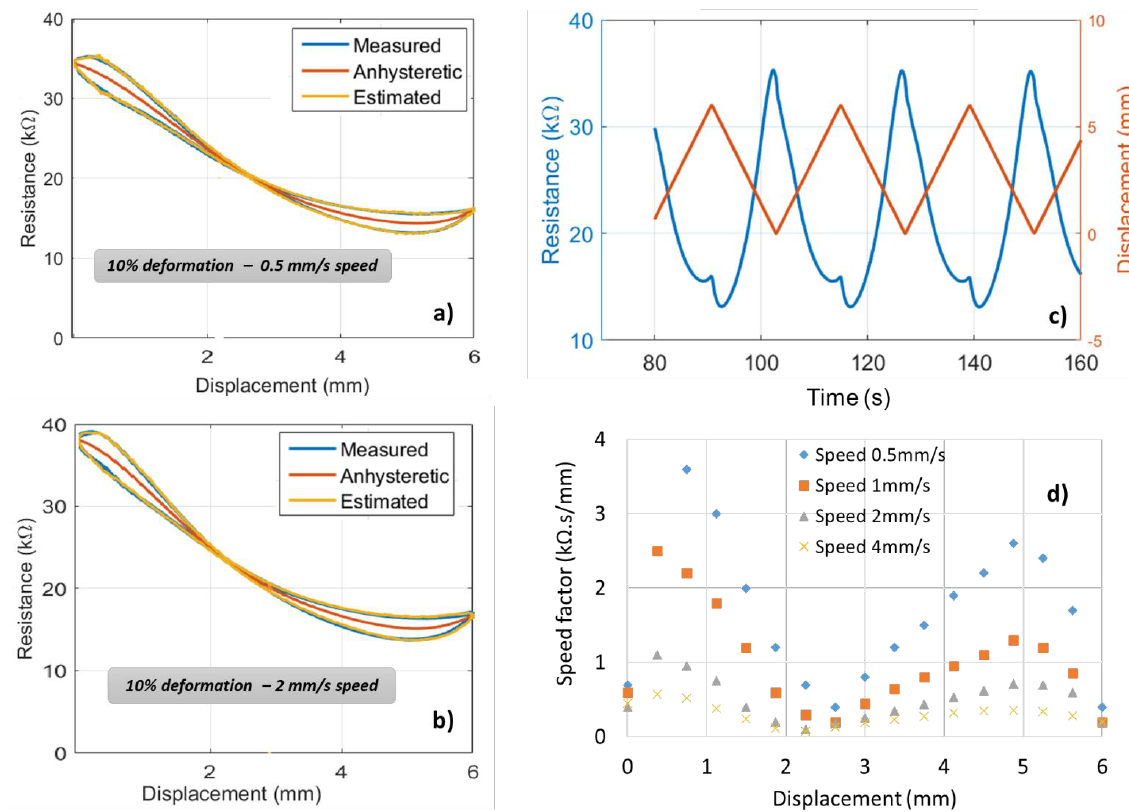
Figure 12. Second ink behavior subjected to a 10% deformation with different dynamics (speeds): ( a , b ) resistance vs. displacement under a speed of 0.5 mm/s and 2 mm/s correspondingly, ( c ) time evolution of resistance and displacement, ( d ) interpolation of the speed factor.